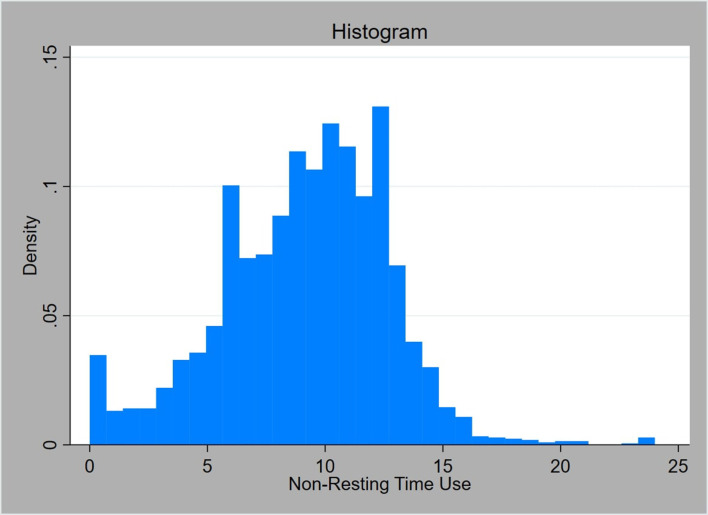
Histogram: non-resting time use.